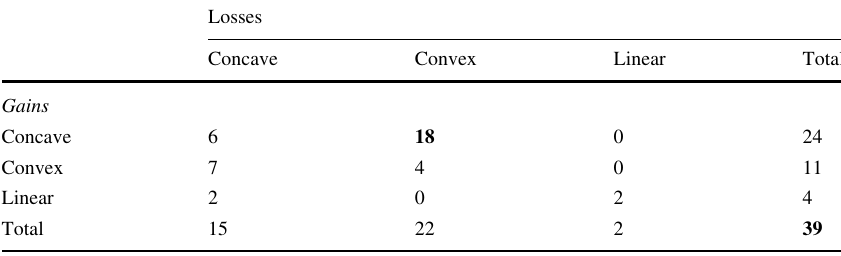
Table 3 Value curvature shape of the participants, where concave gain and convex loss curves are in line with prospect theory